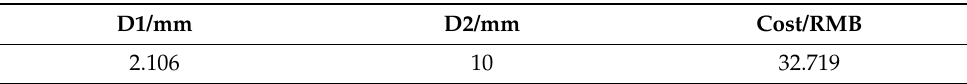
Table 4. Optimal parameter combination of polyvinyl chloride and non-woven fiber (sound trans- mission loss of 22 dB